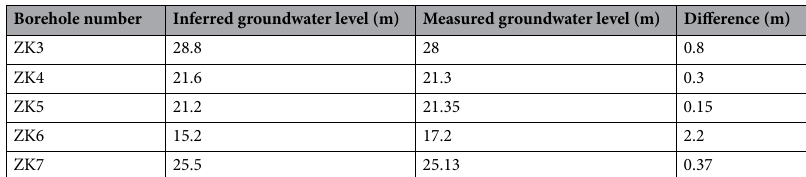
Table 2. Comparison between inferred water level of high-density survey line and measured water level of borehole.